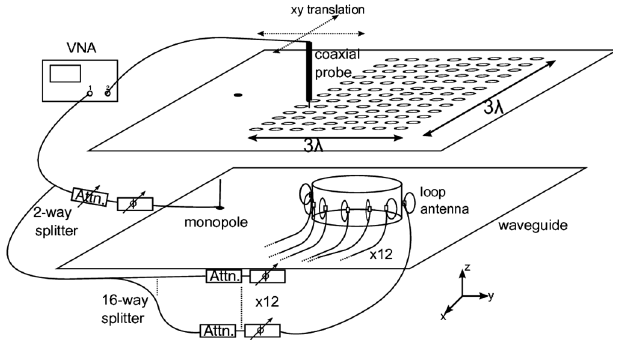
FIG. 3. A schematic of the measurement setup used to measure scattering and cloaking off of an aluminum cylinder. Note that the waveguide plates sit flush against the aluminum cylinder. Also note that absorbers are used to close off the waveguide (not